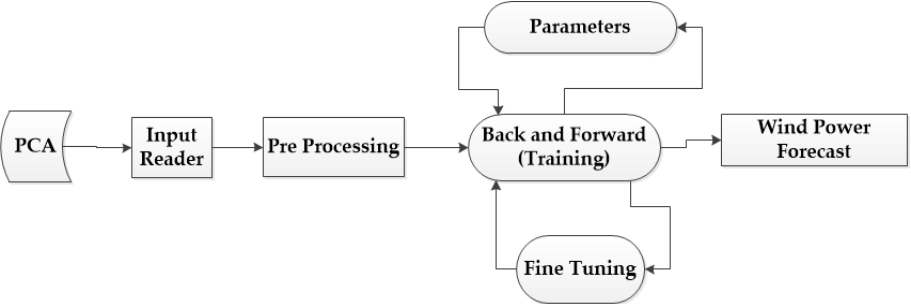
Figure 4. TensorFlow data flow graph for training the preprocessing wind data and wind power forecast.